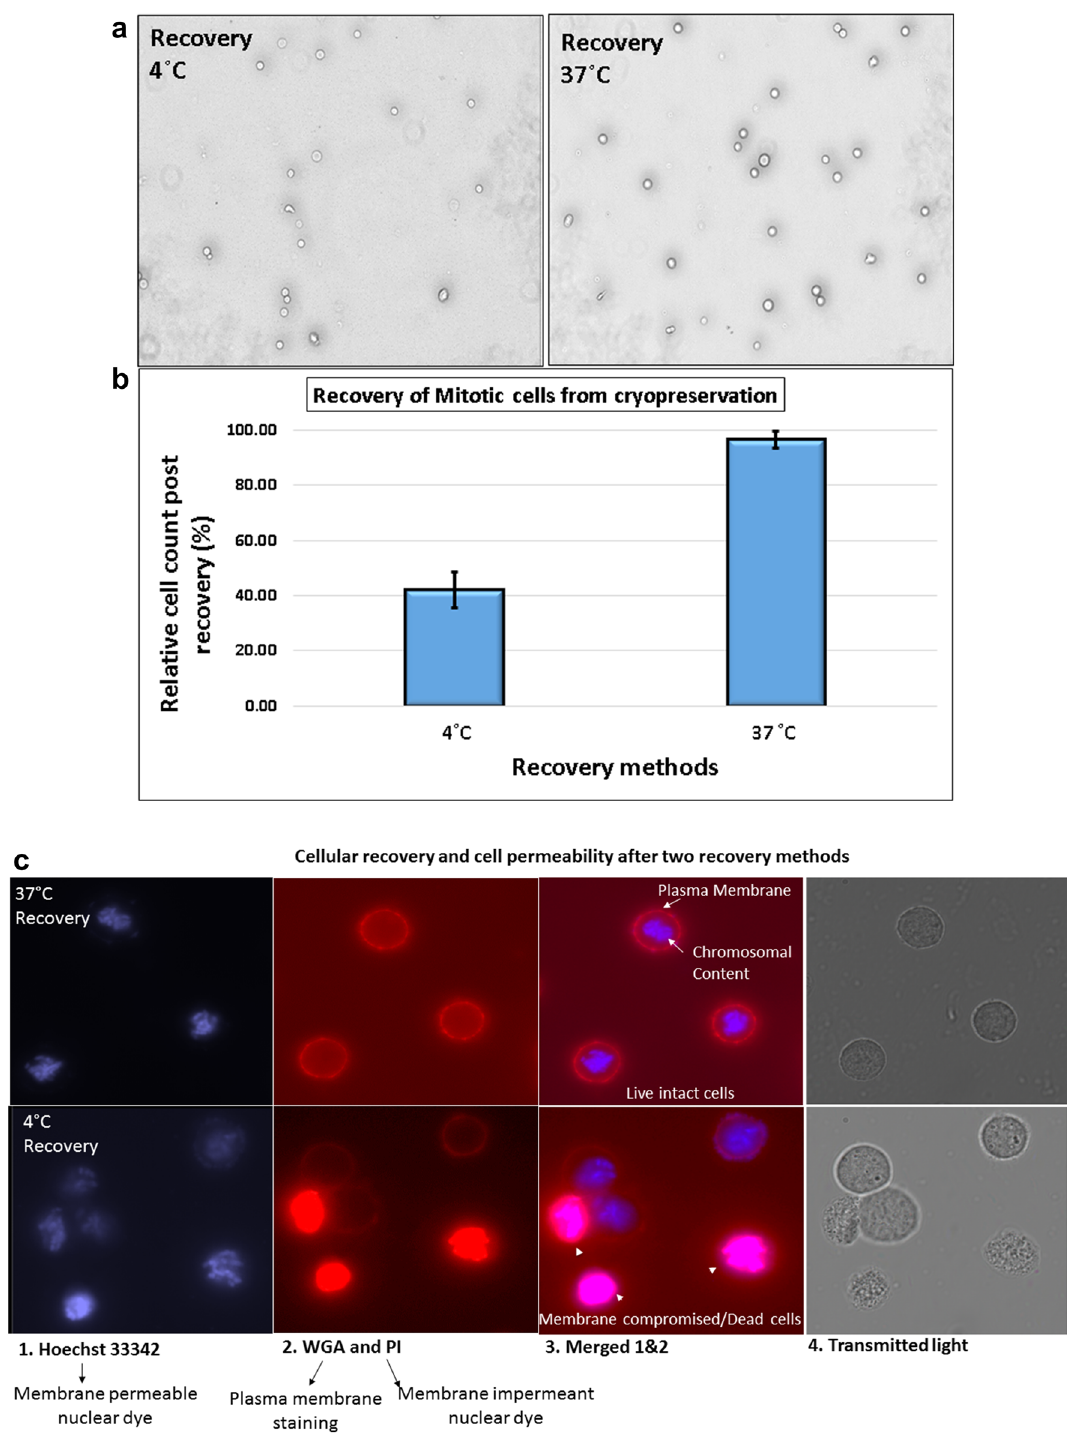
Figure 2. ( a ) Microscopic view of the cells from twin vials which were recovered from cryopreservation using two different methods: at 4 °C (top left) and at 37 °C in presence of Colcemid (top right), ( b ) quantitaive data of cell recovery with the two methods. (Error bar represents Mean ± SD from three independent experiments), ( c ) Damaged and live cell nucleus staining using Hoechst 33342 and PI. PI positive red/pink nuclear content represent dead cells or cell with compromised membrane integrity and blue nuclear content suggest live intact cell. Plasma membrane was marked using WGA staining visible in live intact cells. ( d ) Quantitative data of PI positive cells among the recovered cryopreserved cells using the two recovery methods (Error bar represents Mean ± SD from three independent experiments). ( e ) Progression of recovered mitotic cells from metaphase in presence and absence of Colcemid. ( f ) Quantitative data of kinetics of mitotic index in absence and presence of Colcemid after recovery from cryopreservation (Error bar represents Mean ±